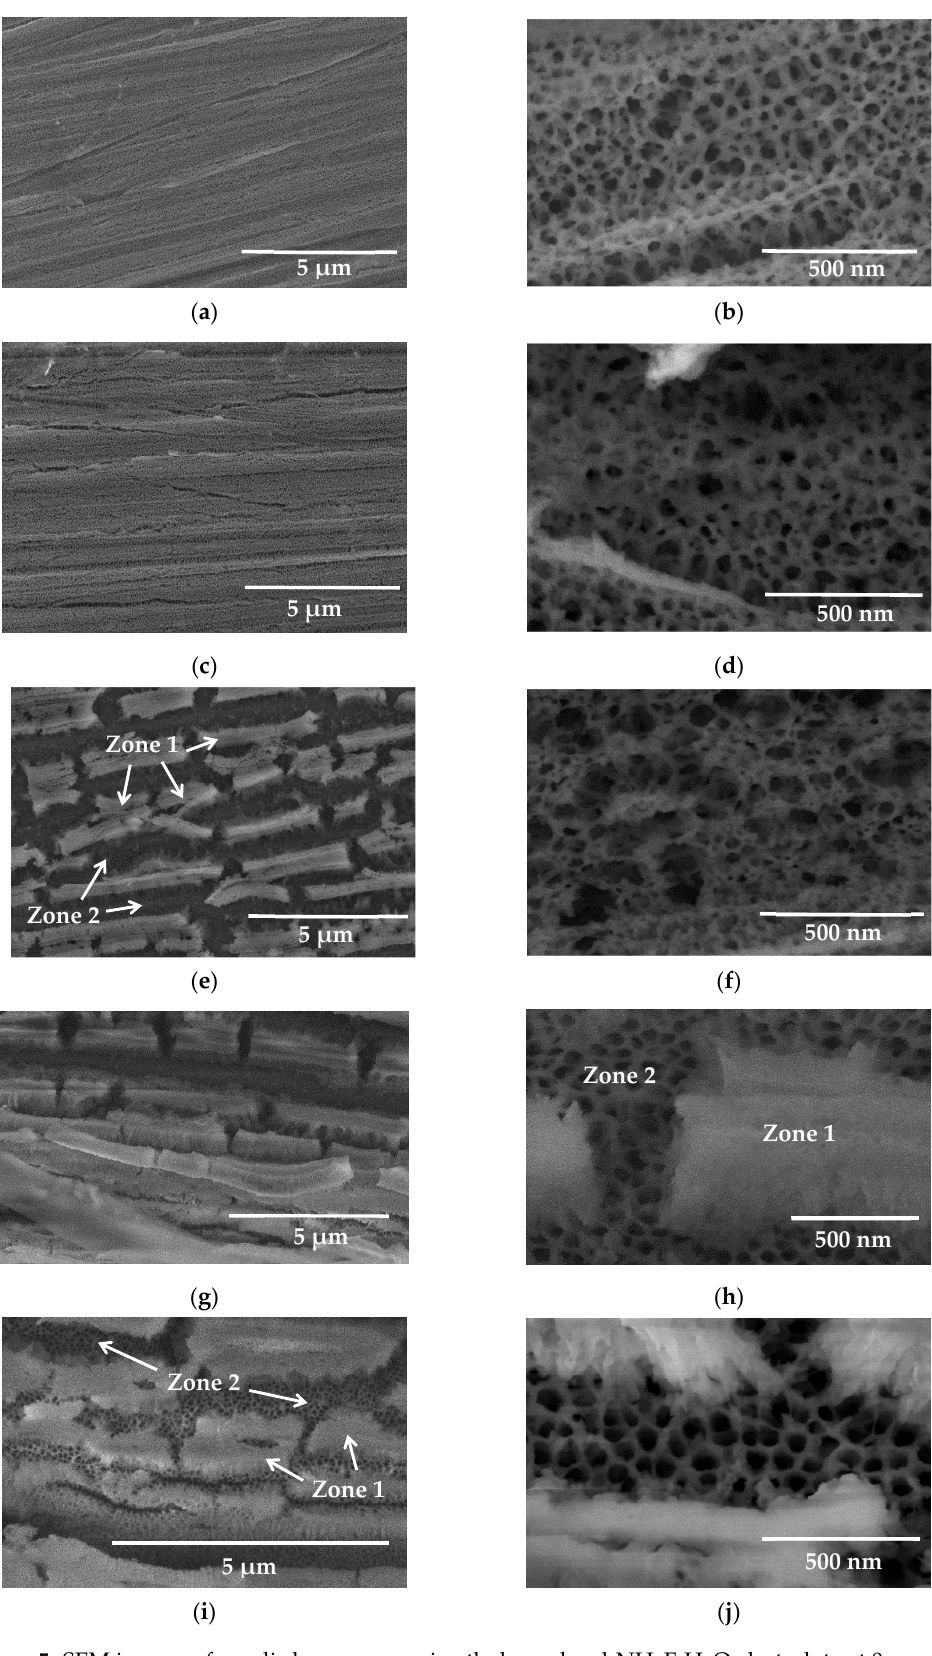
Figure 5. SEM images of anodic layers grown in ethylene glycol-NH 4 F-H 2 O electrolyte at 0 rpm for ( a , b ) 15 min; ( c , d ) 30 min; ( e , f ) 45 min; ( g , h ) 60 min; and ( i , j ) 60 min at 600